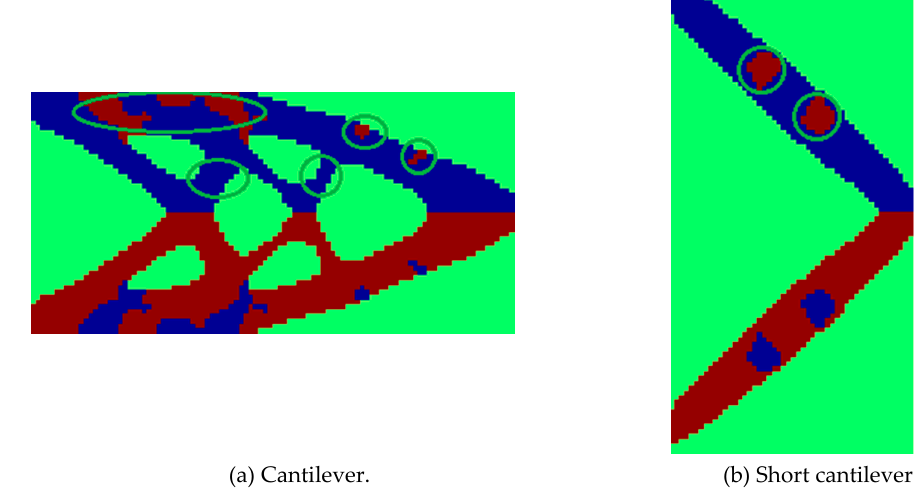
Figure 4. Misconverged local areas. ( a ) Cantilever problem; ( b ) short cantilever problem.